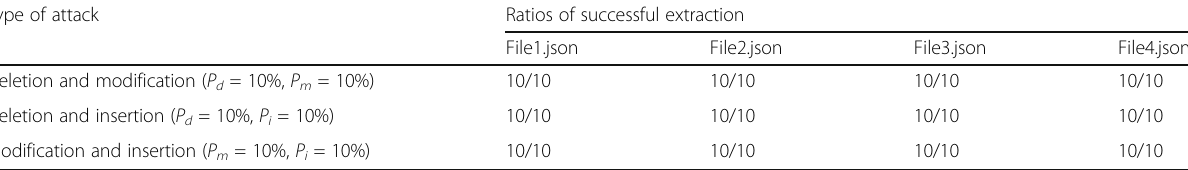
Type of attack Ratios of successful